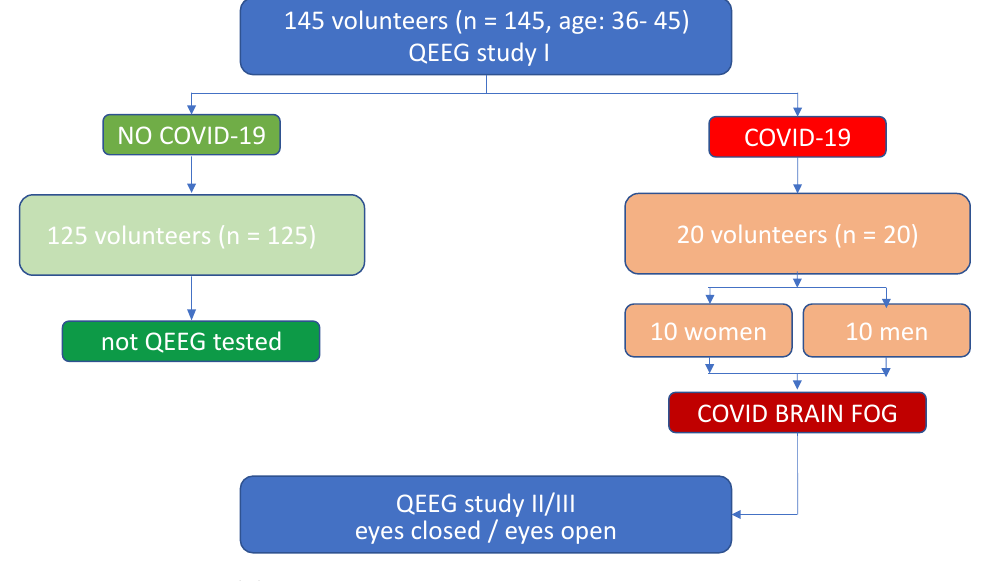
Figure 1. Experimental design.